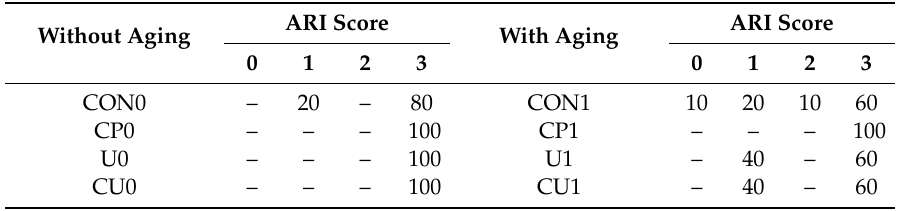
Table 4. The percentage (%) of ARI scores in the groups after shear bond strength test.